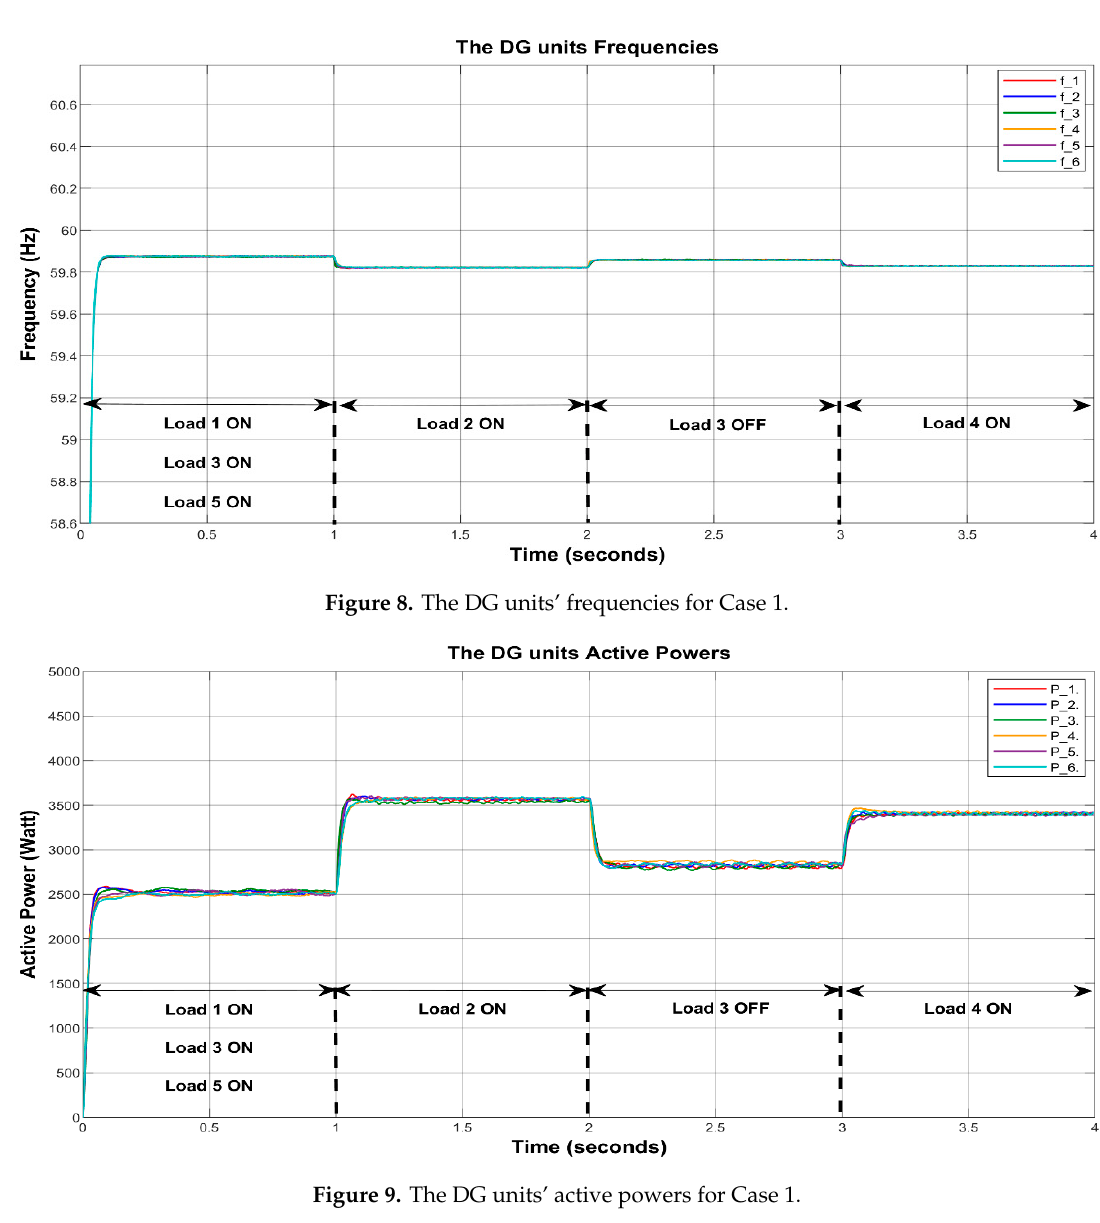
Figure 9. The DG units’ active powers for Case 1.